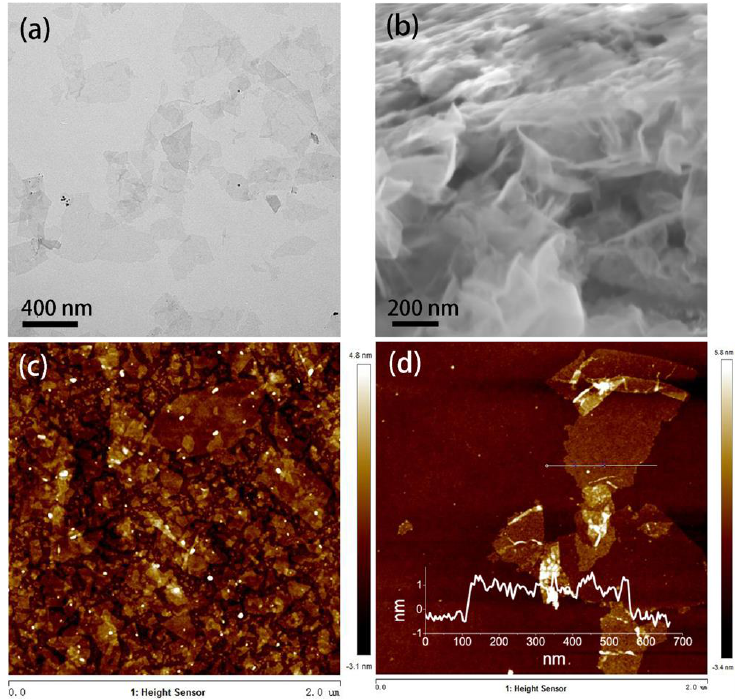
Figure 3. TEM, SEM and AFM images of MoS 2 flakes exfoliated by Li intercalation and sonication [28].